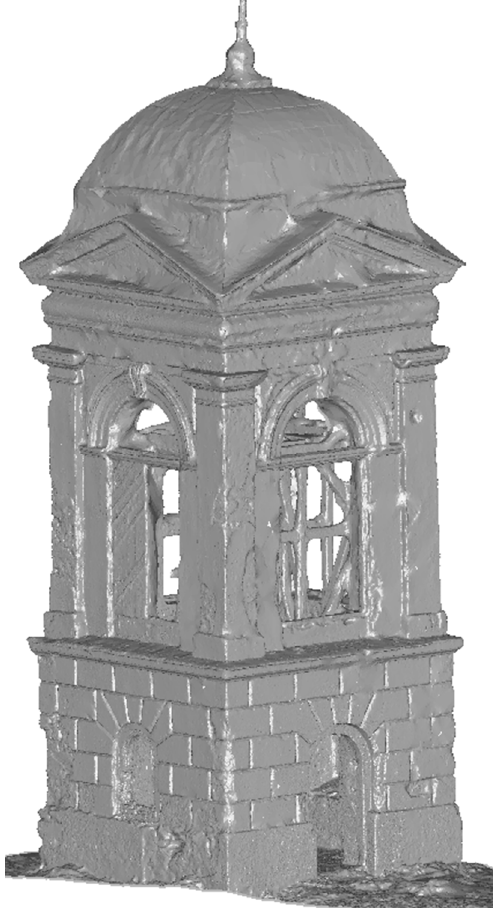
Figure 16. Bottom photo view of wooden bell landing